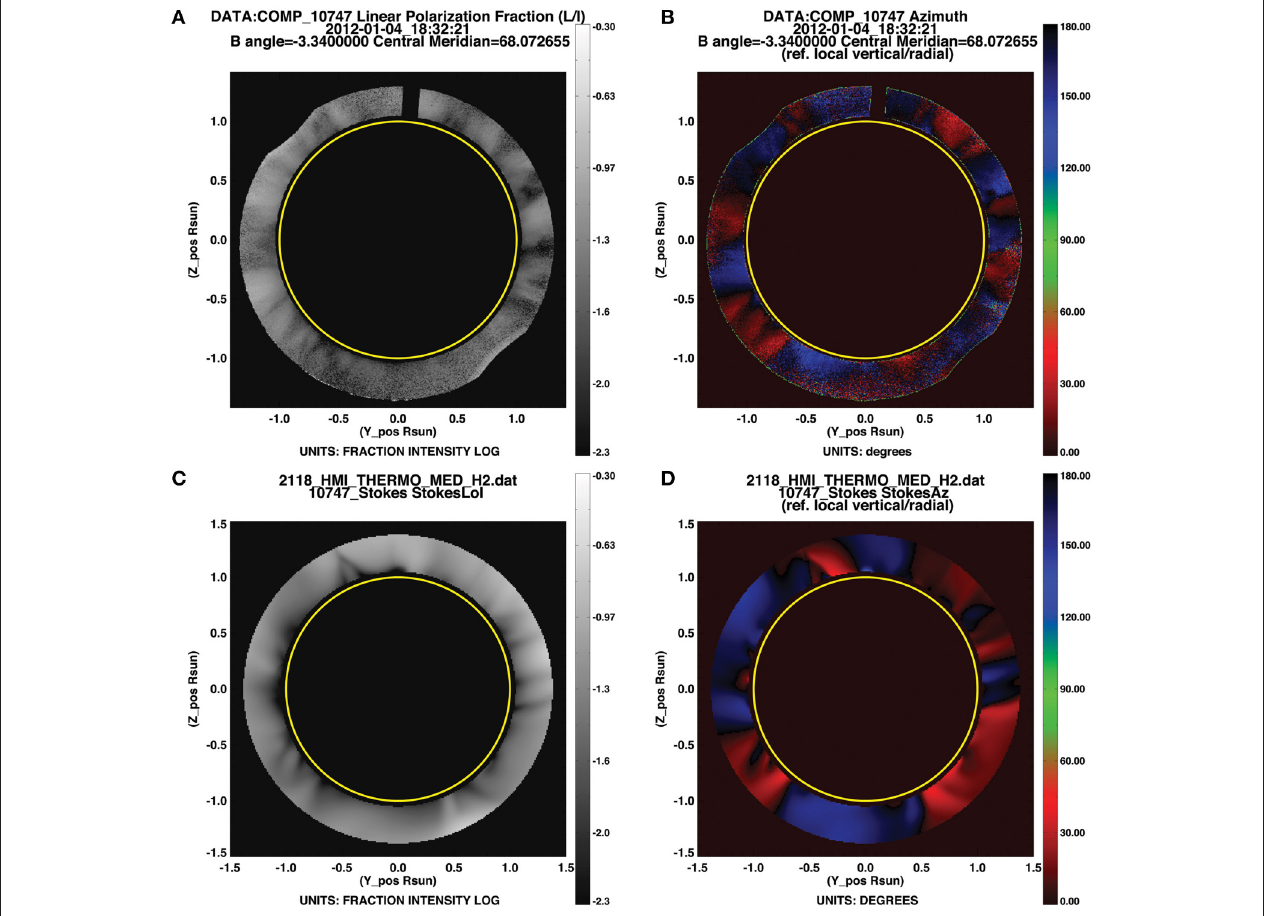
FIGURE 11 | Linear polarization: observations vs. model. (A,B) Fraction and direction of linear polarization. Plots obtained from widget or IDL line commands as in Figures 10B,D , but without the xxmin, xxmax keywords set. (C,D) Same from forward calculation of MAS model. Plots obtained as in Figures 6E,G , with addition of keywords occult=1.05,upoccult=1.29 . Alternatively, (C,D) may be obtained by loading (A,B) from the widget, choosing the PSIMAS model from the drop-down menu, and clicking FORWARD .